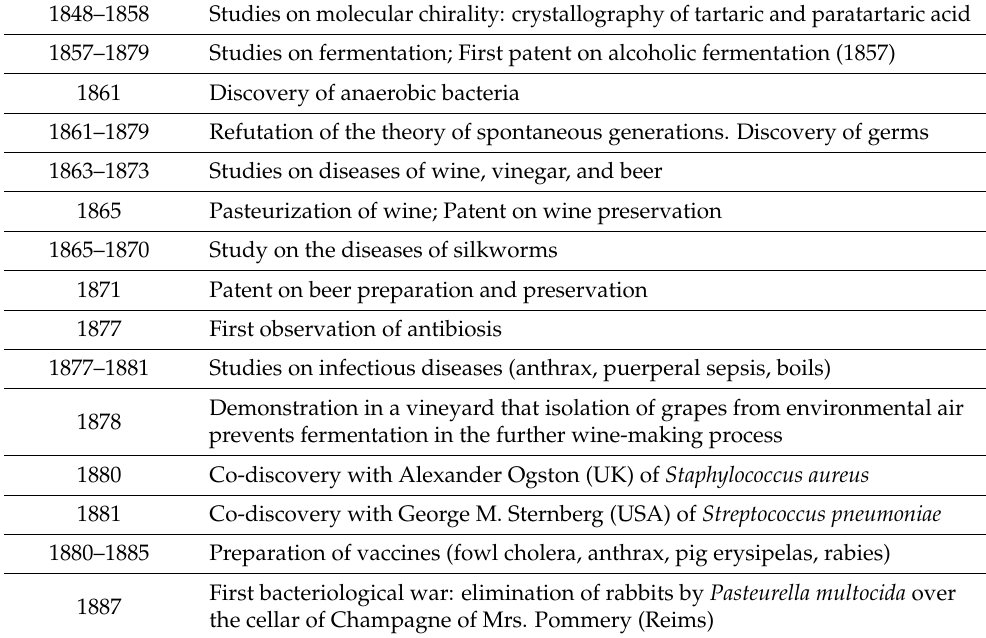
Table 1. Main contributions of Louis Pasteur.